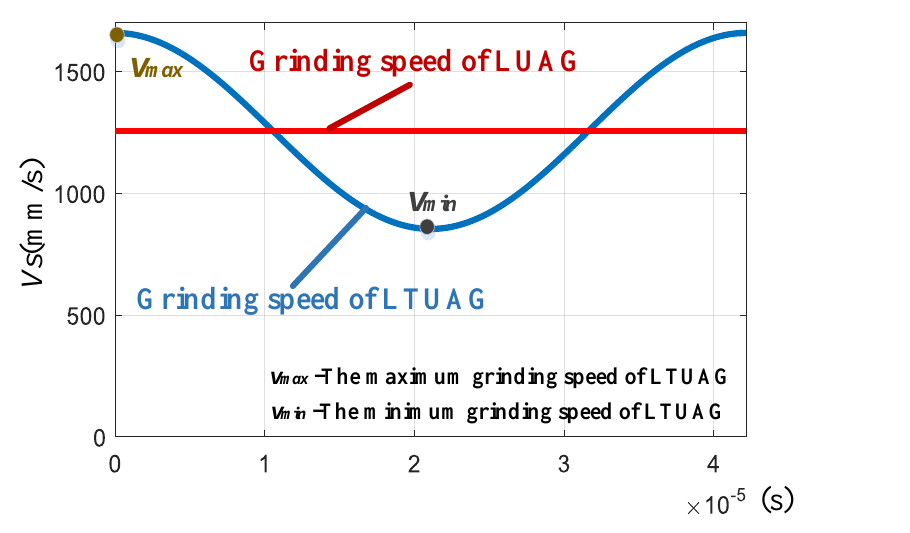
Figure 14. Grinding speed of LTUAG and LUAG.